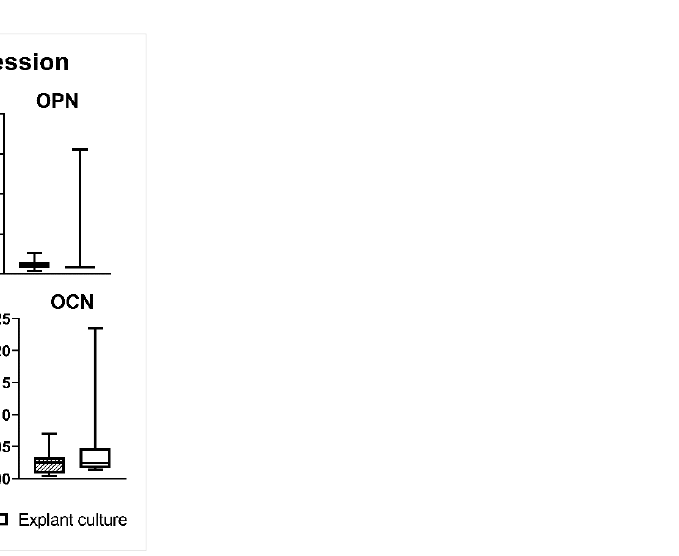
Figure 4. Relative mRNA expression of osteogenic markers assessed for rOBs isolated either by ex- plant culture with enzymatic pre-treatment or by explant culture by qPCR on the day of rOBs seed- ing (day 0).